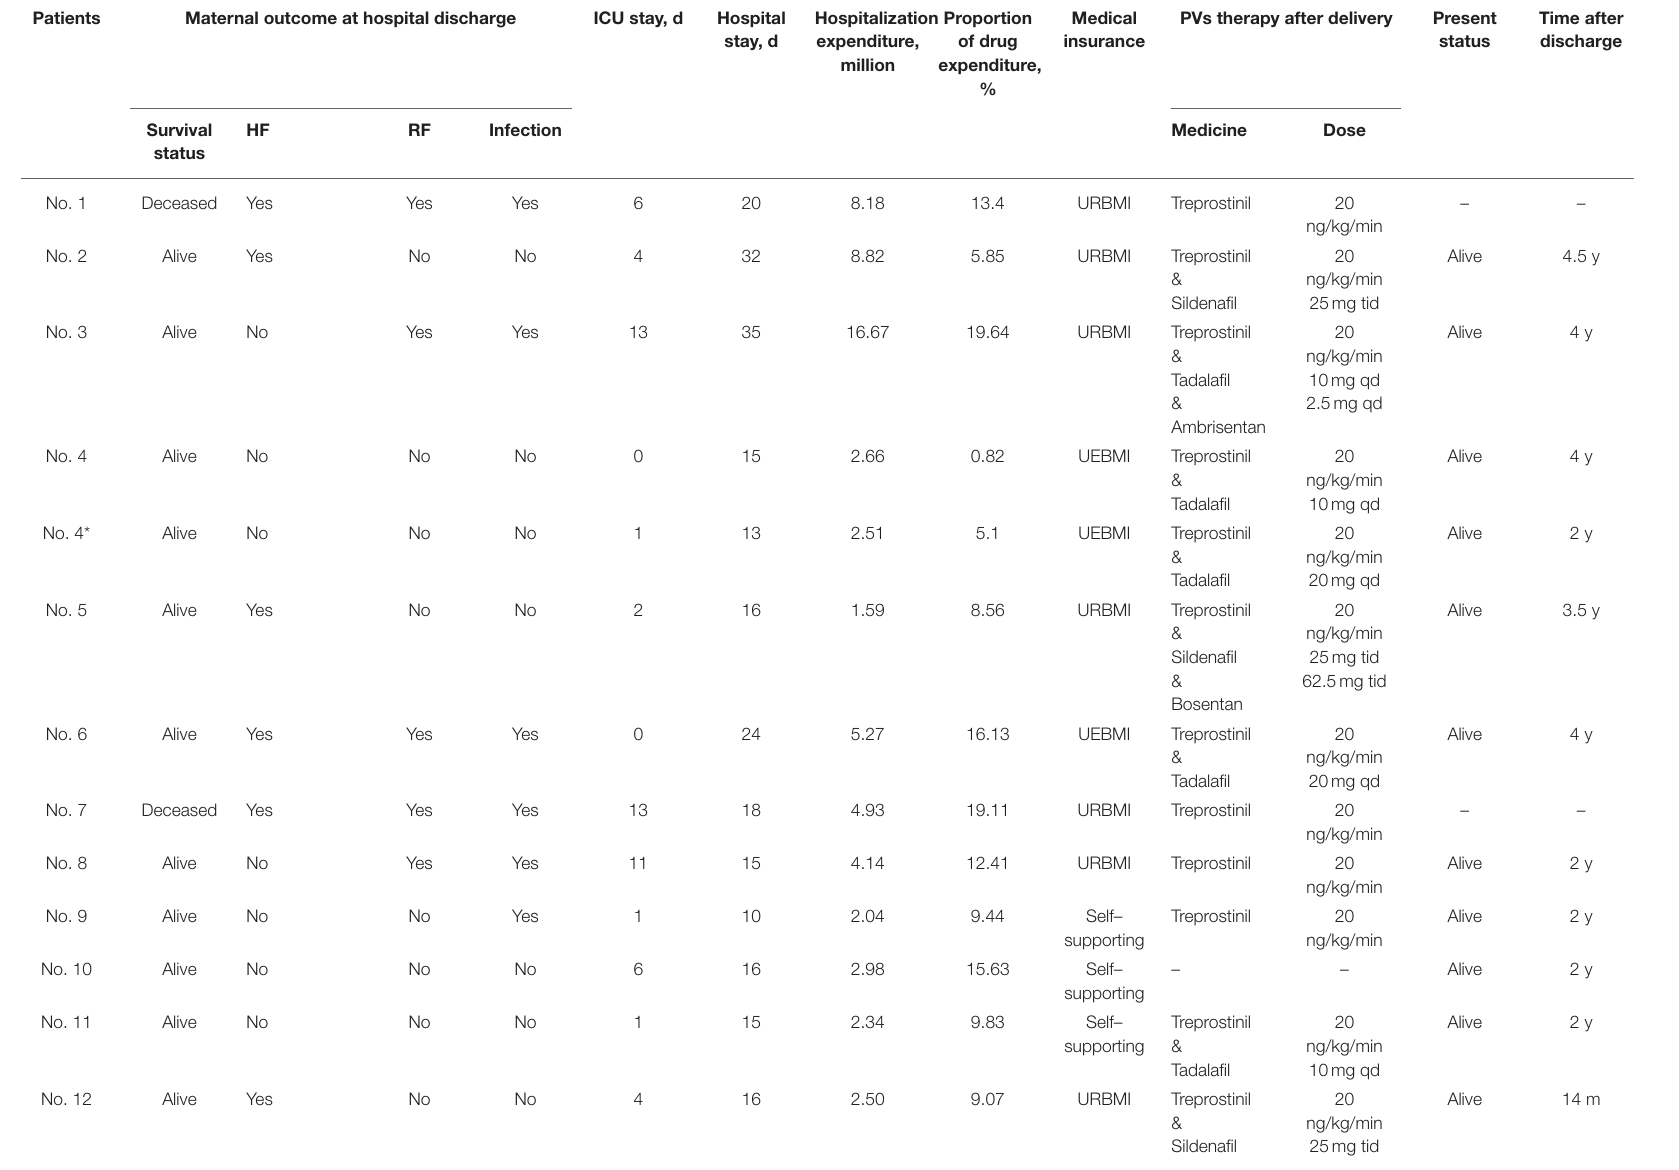
TABLE 4 | Post-operative management and outcome at discharge of PAH patients with pregnancy.